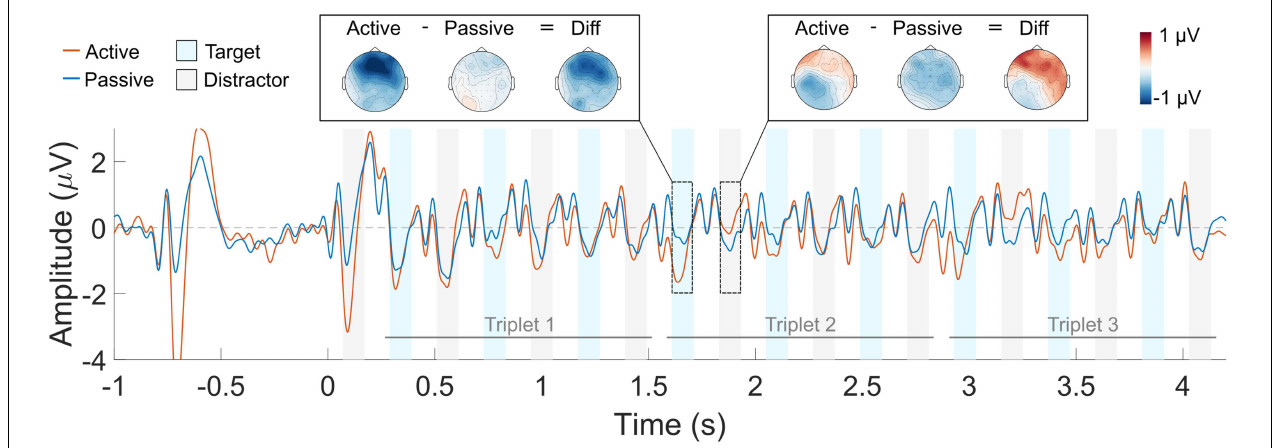
FIGURE 4 | Averaged ERP waveform across the four deviant triplet conditions. The active listening condition is shown in red and the passive listening condition in blue. The blue and gray shaded areas indicate the N1 ERP component time window for the target and the distractor sounds, respectively. Each trace represents the average across nine front-central electrodes (Fz, AFz, FCz, F1, F2, FC1, FC2, AF3, AF4). The scalp topography of the response to a target and a distractor sound is shown for each of the listening conditions and their